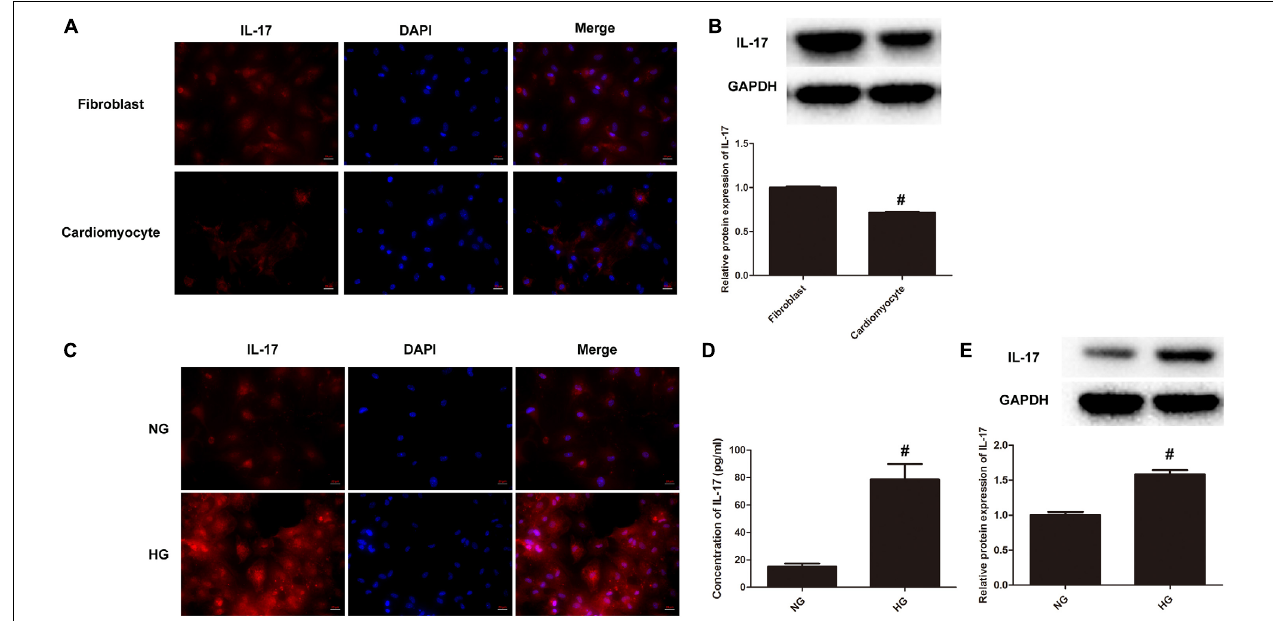
FIGURE 2 | IL-17 production significantly increases upon HG treatment. (A) Immunocytochemical staining was conducted using anti-IL-17 (red) in both primary cardiomyocytes and fibroblasts as above-mentioned. Nuclei were counterstained by DAPI (blue). Scale bars, 20 µ M. (B) Cell lysates collected from both primary cardiomyocytes and fibroblasts were processed for western blotting to determine the protein expression of IL-17. Protein levels of IL-17 were quantitated by densitometric analysis using ImageJ (U.S. National Institutes of Health, Bethesda, MD, United States), normalized to GAPDH. Control group was arbitrarily set a value of 1, # p < 0.01. (C) Primary cardiomyocytes and fibroblasts were incubated with 5.5 mM glucose (NG) or 25 mM glucose (HG) for 24 h in DMEM supplemented with 10% FBS at 37 ◦ C incubator with 5% CO 2 , followed by immunocytochemical staining as above-mentioned. (D) Cell supernatants of primary cardiomyocytes and fibroblasts treated with either HG or NG were collected and assayed for IL-17 using ELISA kits, # p < 0.01. (E) Cell lysates of primary cardiomyocytes and fibroblasts treated with either HG or NG were collected and processed for western blotting to examine the protein expression of IL-17 as above-mentioned, # p < 0.01.